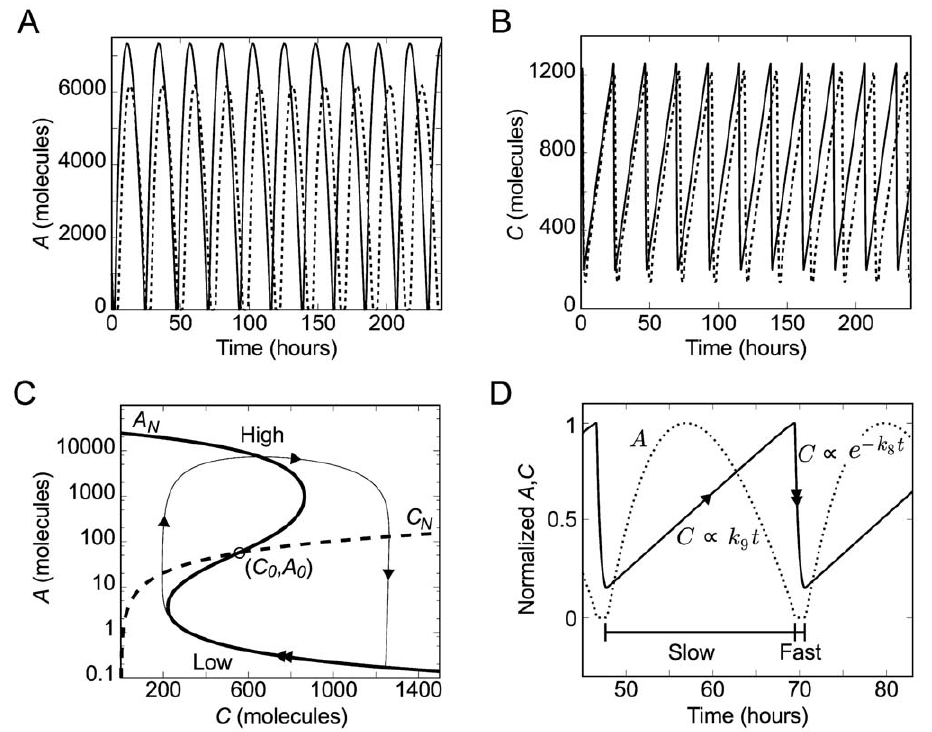
Figure 5. Model of the genetic oscillator reduced by QSSA. A, B. Comparison between the reduced (solid line) and complete (dashed line) deterministic simulation of the time evolution of A and C , respectively. C. Phase plane. Limit cycle (thin solid line) and nullclines A N (thick solid lines) and C N (thick dashed line). The unstable fixed point of the system (marked by circle 0 ) is C 0 ~ 552 : 4 and A 0 ~ 56 : 3 molecules. The A N and C N nullclines are the solution of equations dA = dt ~ 0 and dC = dt ~ 0 , respectively. The two branches in the nullcline A N are called ‘‘high’’ and ‘‘low’’. D. Slow and fast stages in the reduced system. The solid line is C and the dotted line is A . C exhibits a sawtooth waveform. (The arrows in C and D represent the direction of the oscillations. One and two arrows mean slow and fast stages,